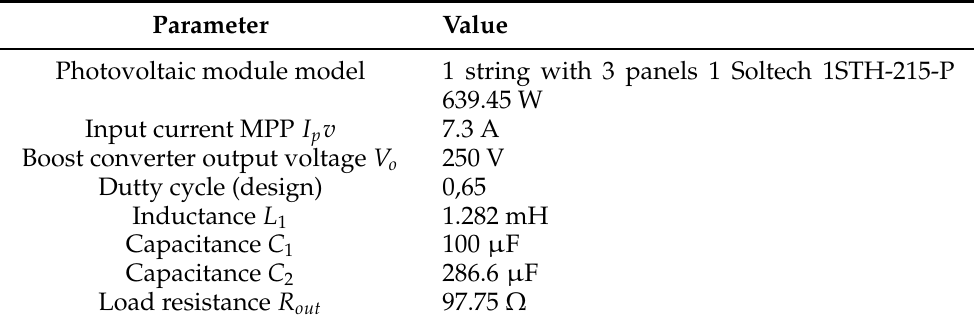
Table 1. PV Arrangement Data.